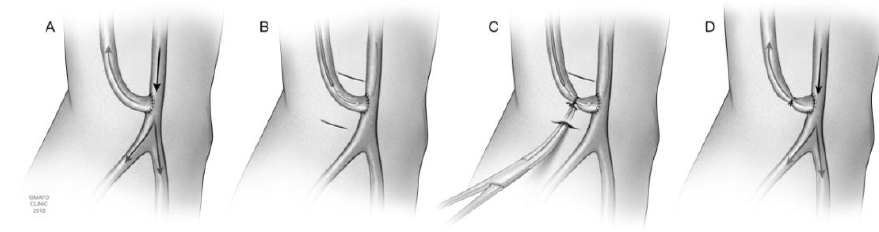
Figure 4. MILLER (minimally invasive limited ligation endoluminal-assisted revision) steps. ( A ) A majority of blood flow is diverted into the brachiocephalic arteriovenous fistula (AVF), resulting in less flow to the distal extremity, resulting in steal syndrome. ( B ) Angioplasty balloon traversing the AVF anastomosis in a retrograde fashion. Incisions are made cranially and caudally to the fistula. ( C ) Dissection is performed with tunneling of a hemostat beneath the fistula. Monofilament suture is also passed underneath the fistula. The suture is tied firmly around the fistula, but still below the skin, with the endovascular balloon in place as a guide. ( D ) Post-procedural blood flow is redirected with more blood flowing distally. Copyright 2018 Mayo Foundation for Medical Education and Research.